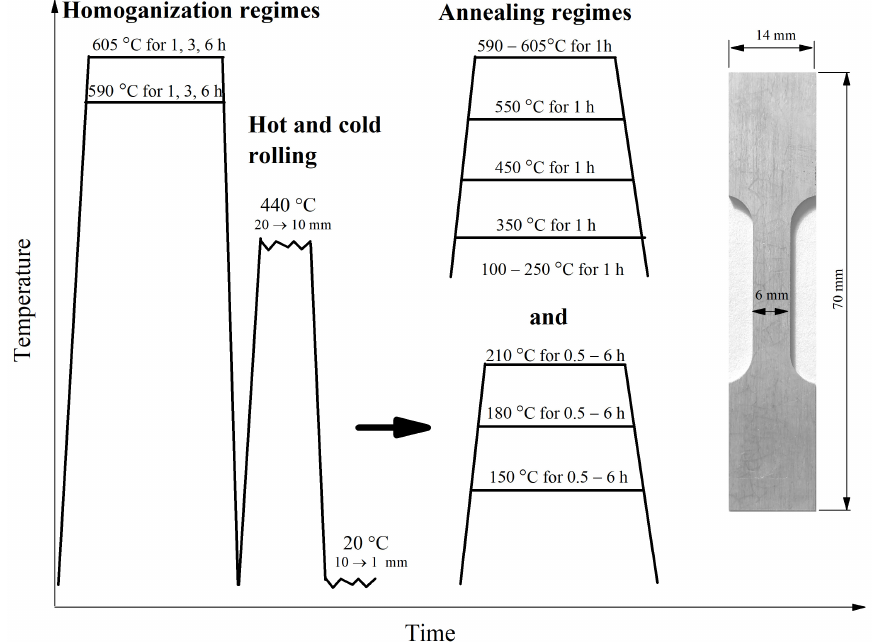
Figure 1. Scheme of the thermo-mechanical treatment of the alloys and tensile test sample. Table 1. Chemical composition of the alloys, wt %.